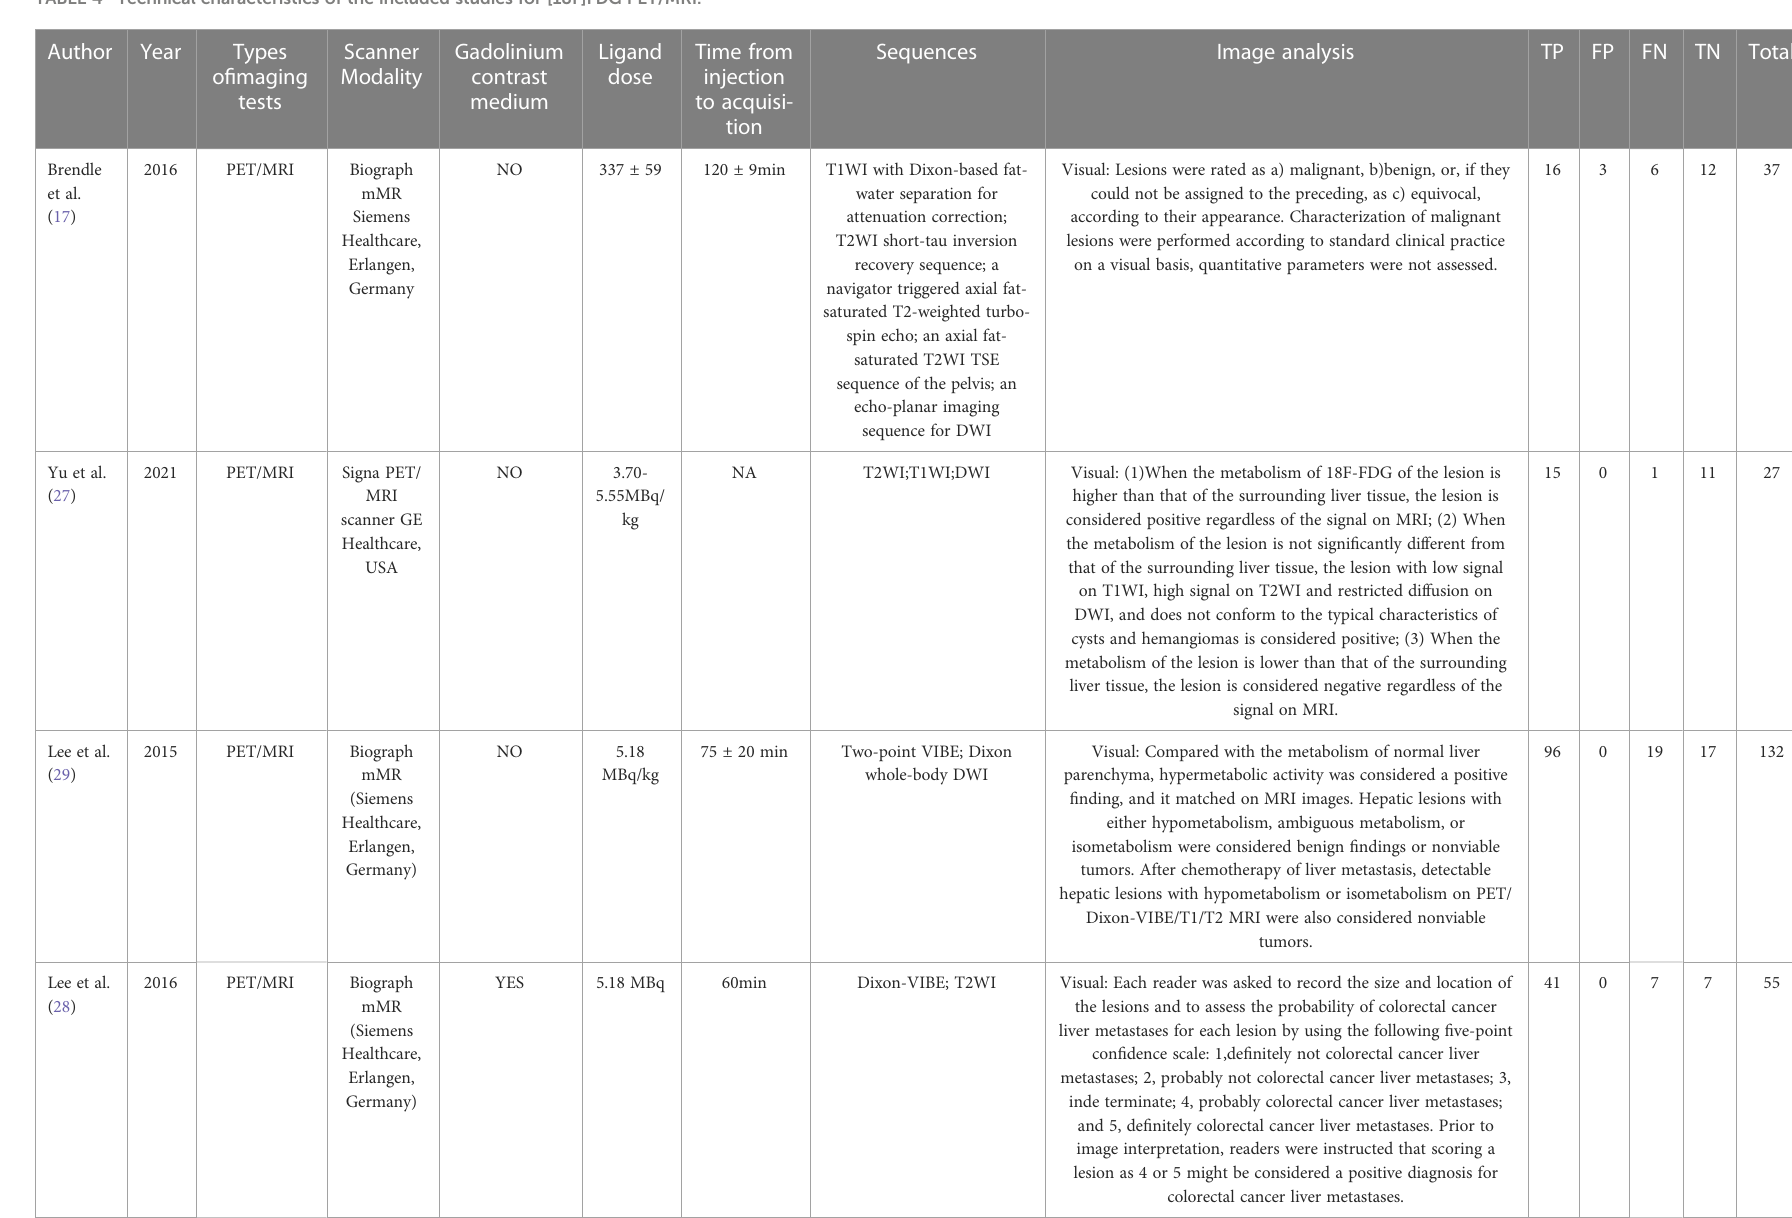
TABLE 4 Technical characteristics of the included studies for [18F]FDG PET/MRI.